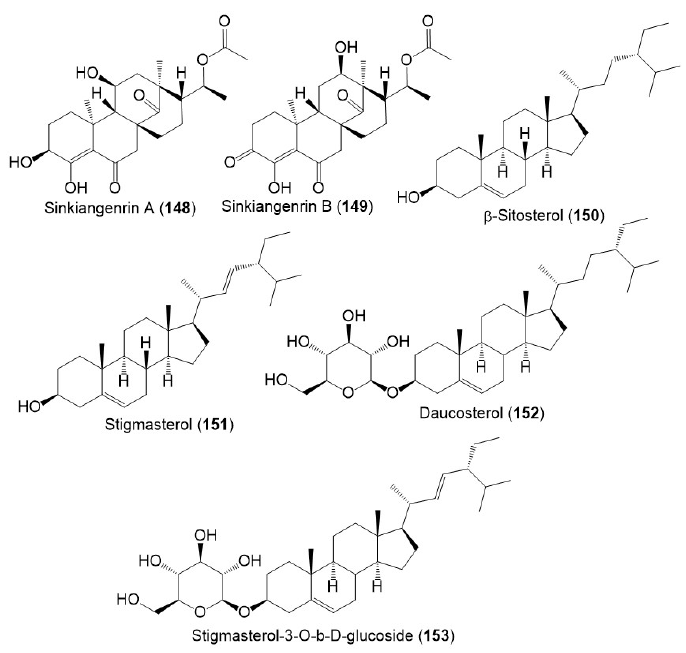
Figure 17. Structures of sterols ( 148 – 153 ) reported from F. sinkiangensis .